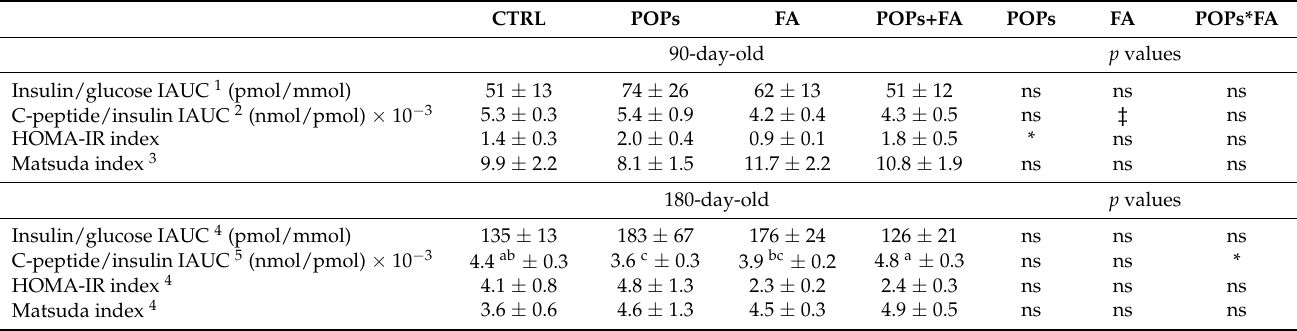
Table 4. Estimates of insulin sensitivity, insulin clearance (hepatic extraction) and β -cell function in F1 male rats. CTRL POPs FA POPs+FA POPs FA POPs*FA 90-day-old